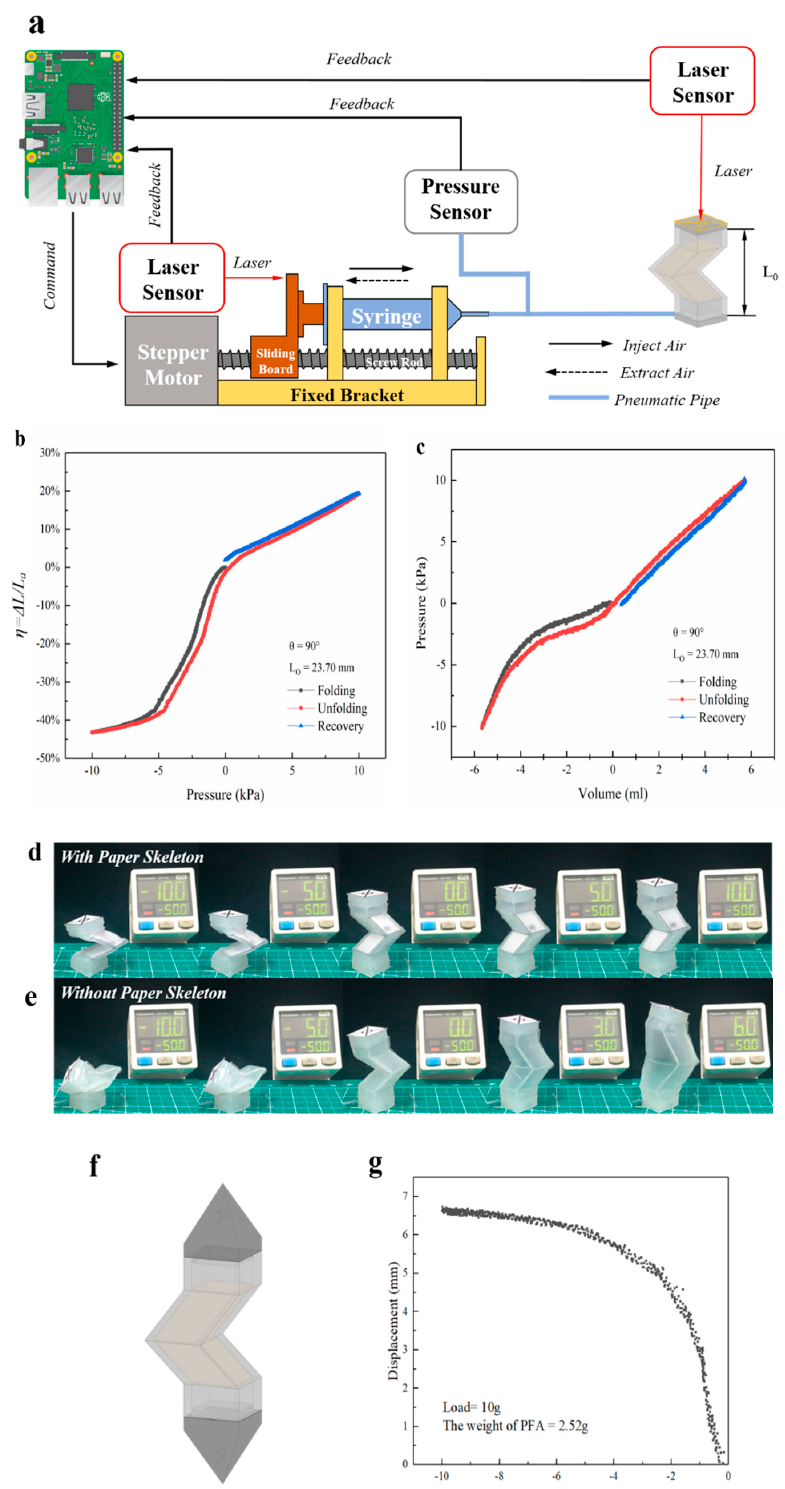
Figure 8. ( a ) The experimental setup for measuring; ( b ) The pressure–displacement curve; ( c ) The volume–pressure curve; ( d ) The PFA with a paper skeleton under di ff erent pressure from − 10 kPa to 10 kPa; ( e ) The PFA without a paper skeleton under di ff erent pressure from − 10 kPa to 6 kPa; ( f ) The PFA designed as a pneumatic muscle; ( g ) The behavior of the PFA versus